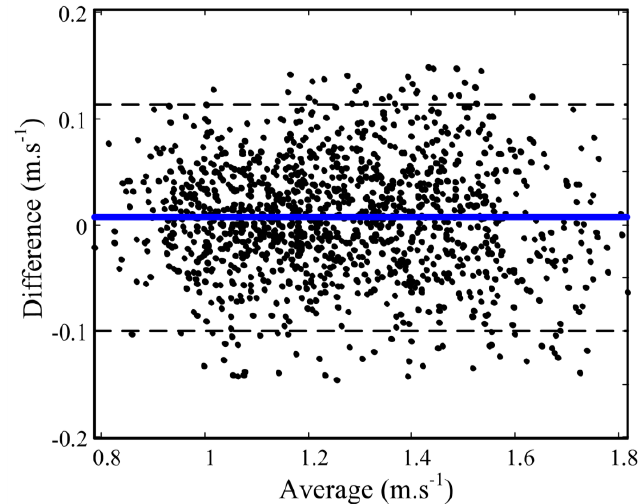
Figure 5. Bland-Altman plot, representing mean (x-axis) and difference (y-axis) between the values estimated by body-worn IMU and reference tethered apparatus (SpeedRT). Limits of agreement (dot lines) are located at mean difference ±1.96 standard deviation of the